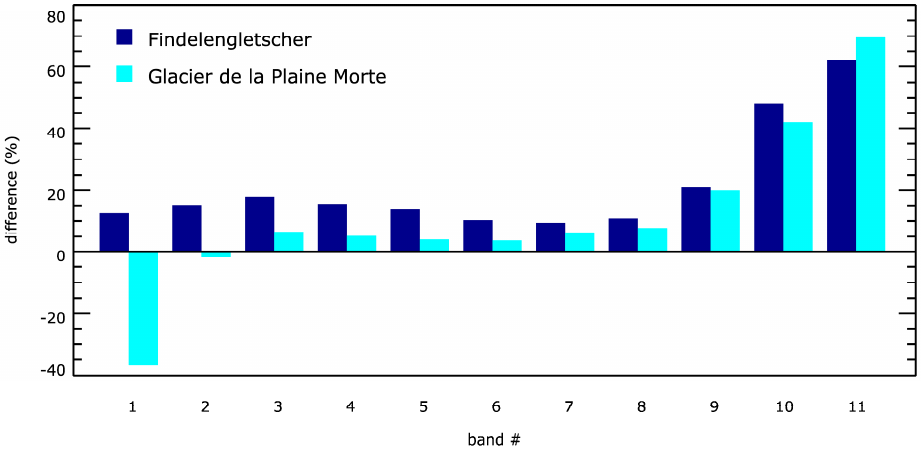
Figure A4. Average difference in percent before and after calibration of Sentinel-2 scenes per individual band.